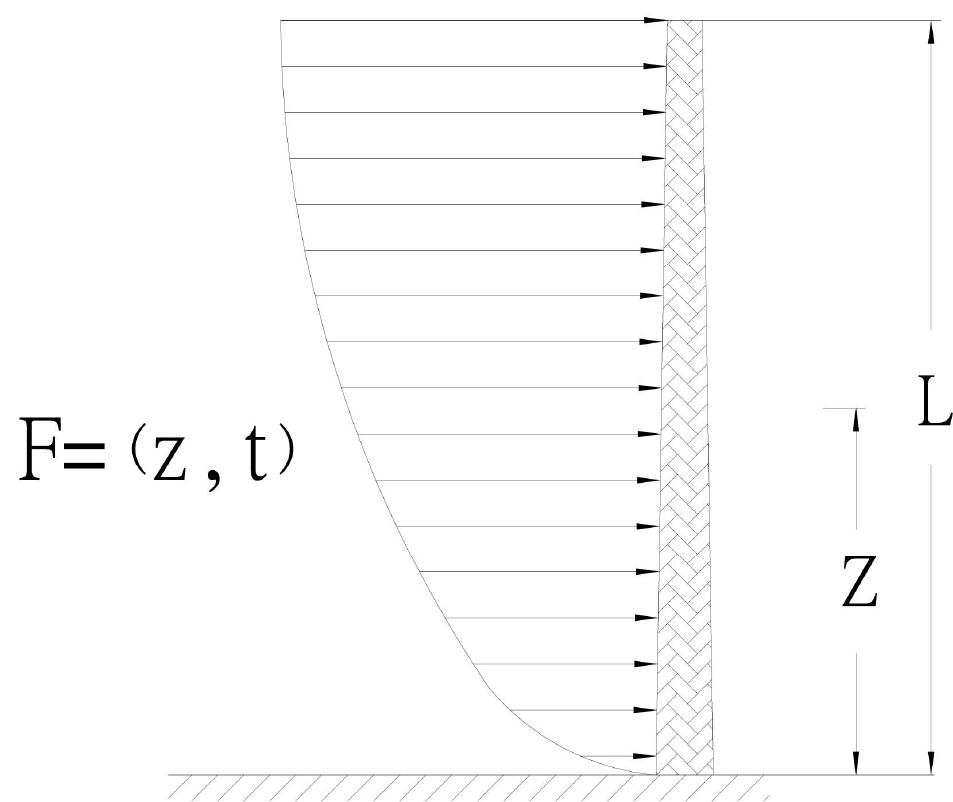
Figure 1. Structural model of wind power tower excited by wind load. The structure is a cantilever beam with variable section, and its modal shape curve is solved by Rayleigh-Ritz method. Based on the boundary conditions conforming to the structure, the i th modal test function is defined as the following expression